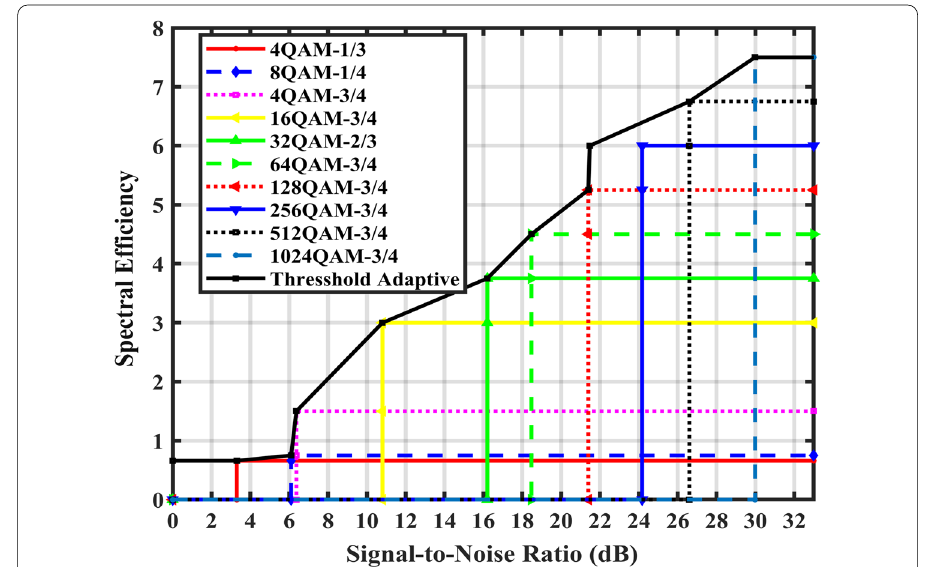
Fig. 20 Spectral efficiency versus SNR for BER of 10 − 5 for fixed code modulation pair and ACM schemes. The spectral efficiency (b/s/Hz) performance comparison with fixed and adaptive modulation code